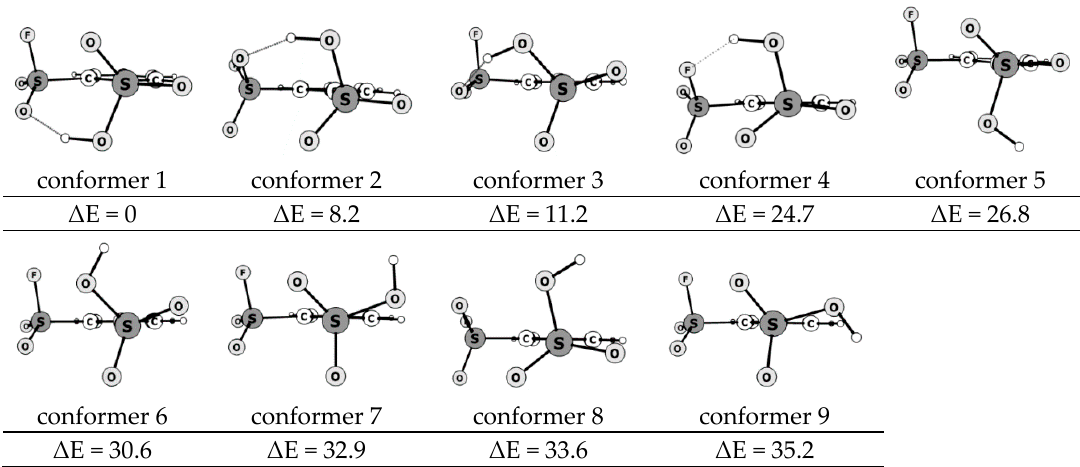
Figure 3. The structure of the 2-SO 2 F-BSAconformers and their relative energies ( Δ E, kJ mol − 1 ).